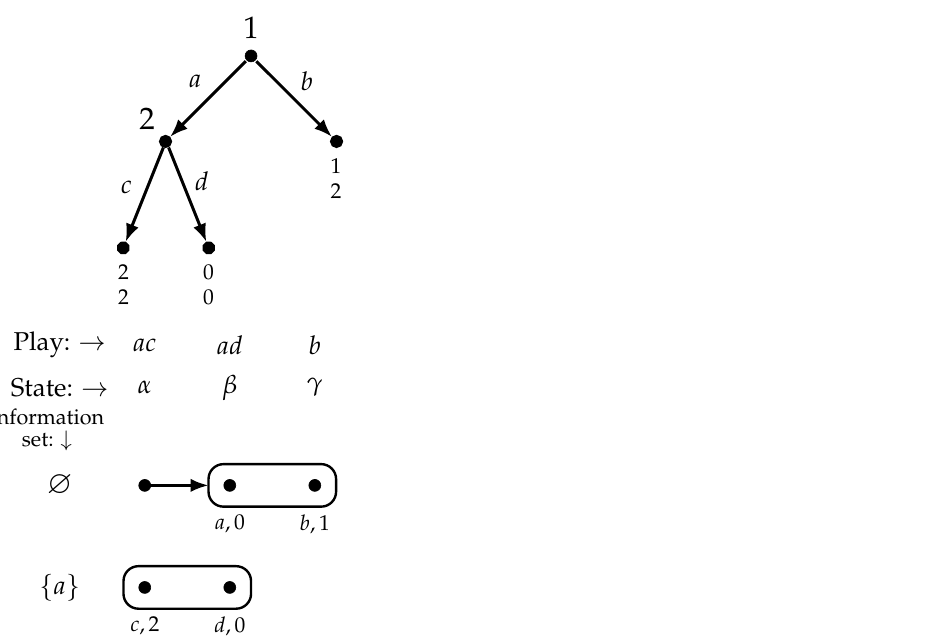
Figure 9. γ ∈ R ∩ T ∩ C ∩ A but at γ Player 1 does not believe that Player 2 is